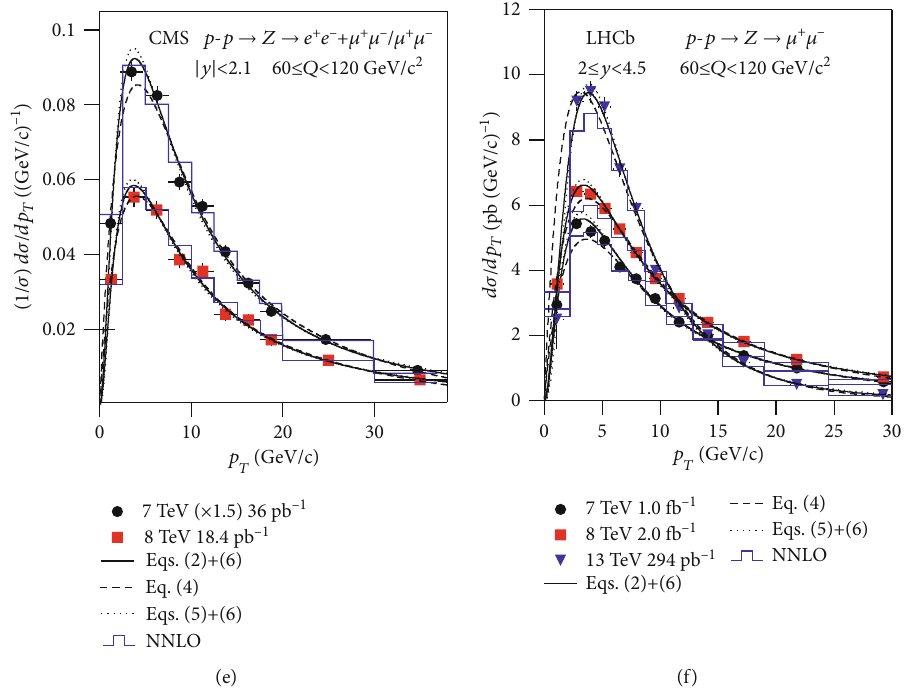
ffiffi p ℓ (cid:1) ℓ [with di ff erent conditions ( s , Q , and y )] produced by the Drell-Yan process in T spectra of (cid:1) ℓ is shown in the panels, see text in subsection 3.3 for the meanings of histograms which are